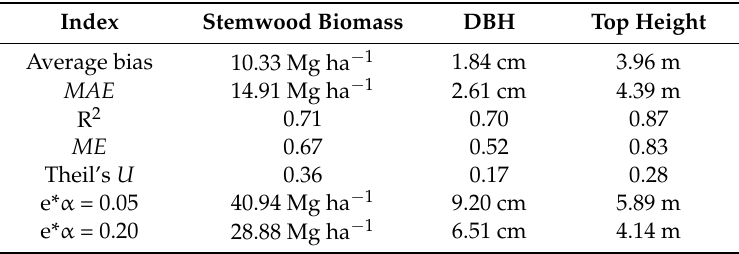
Figure 1. FORECAST predictions (solid lines) and field data obtained for Metasequoia glyptostroboides plantations (dots) for stemwood biomass (top panel), average DBH (medium panel), and dominant top height (bottom panel). Residuals for the linear regression of observed vs. predicted data are in the small panel for each variable. DBH = diameter at breast height. Table 1. Indexes of FORECAST performance for simulation of Metasequoia glyptostroboides plantations established on sites of medium quality (SI = 16) in Shanghai, China. MAE = mean absolute error; ME = modelling efficiency; e* = Freese’s (1960) critical error.